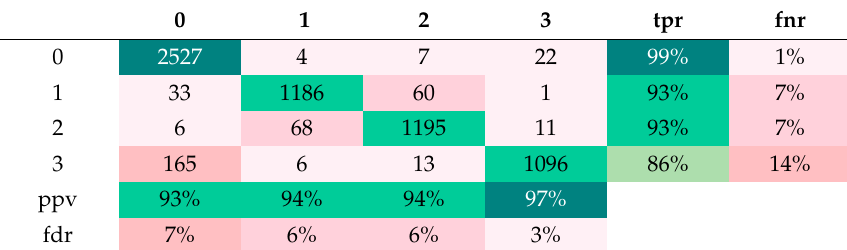
Table 5. Confusion matrix for the k NN algorithm when k =